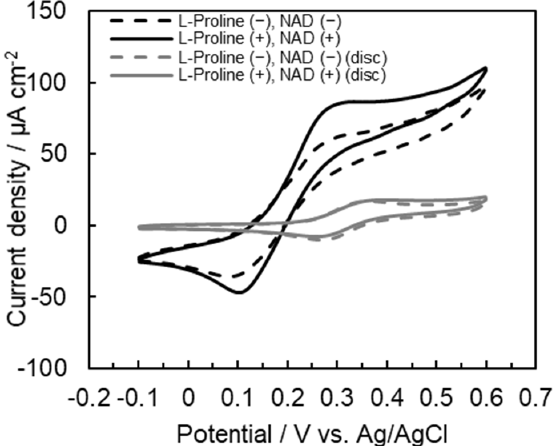
Table 1. Comparison of microfluidic electrode with disc electrode.